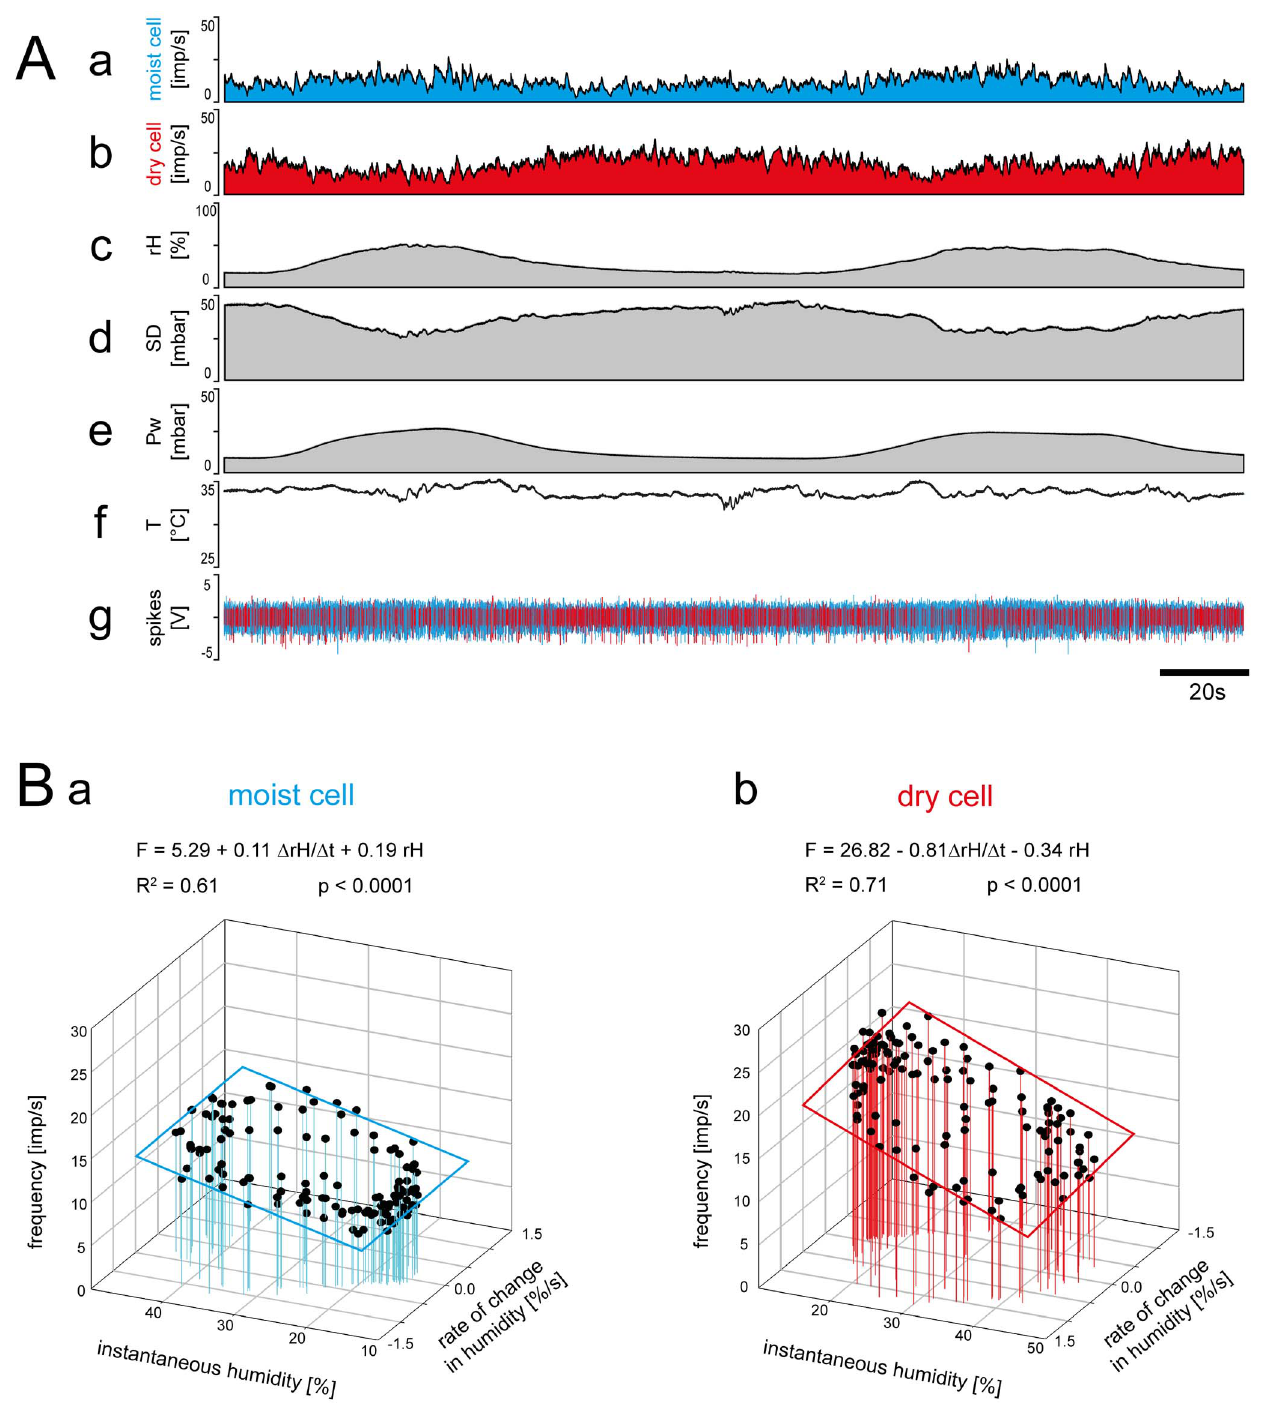
Figure 6. Simultaneously recorded responses of a pair of moist and dry cells from a single sensillum to medium amplitude changes in humidity. A. Time course of the responses and the parameters controlled during the recording, and the corresponding activity of the moist and dry cells. a and b , instantaneous impulse frequency of both cells. c , time course of the relative humidity. d , time course of the saturation deficit. e , time course of the water vapor pressure. f , time course of the temperature. g , digitized action potentials of the moist and dry cells recorded with a single electrode and discriminated on-line. B. Impulse frequency of the moist and dry cells during the oscillations in relative humidity shown in A plotted as a function of instantaneous relative humidity and its rate of change. Multiple regressions which utilize 3-dimensional planes ( F = a + b drH/dt + c rH ; where F is the impulse frequency, and a the height of the regression plane) were calculated to determine the simultaneous effects of the rate of change in the relative humidity ( b slope) and the instantaneous relative humidity ( c slope) and the response frequency of both cell types. Pw water vapor pressure, R 2 coefficient of determination, rH relative humidity, SD saturation deficit, T temperature; V volt.